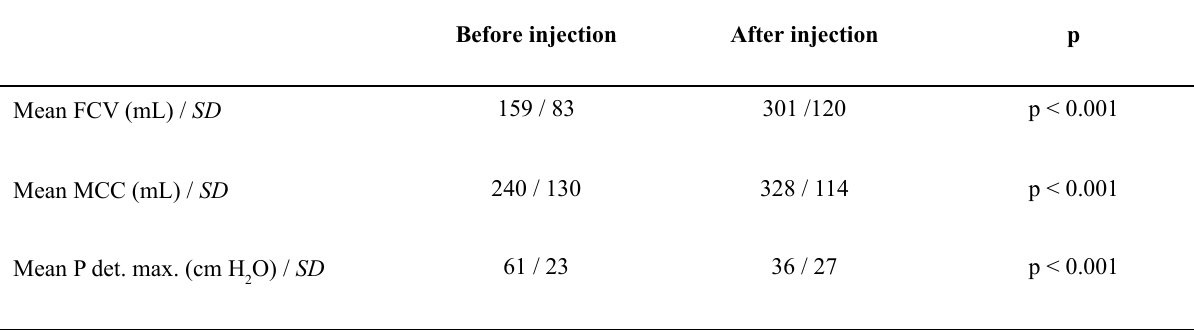
Table 1 - Global results. Urodynamics efficacy of the injection therapy in 71 patients with MS and refractory over - active